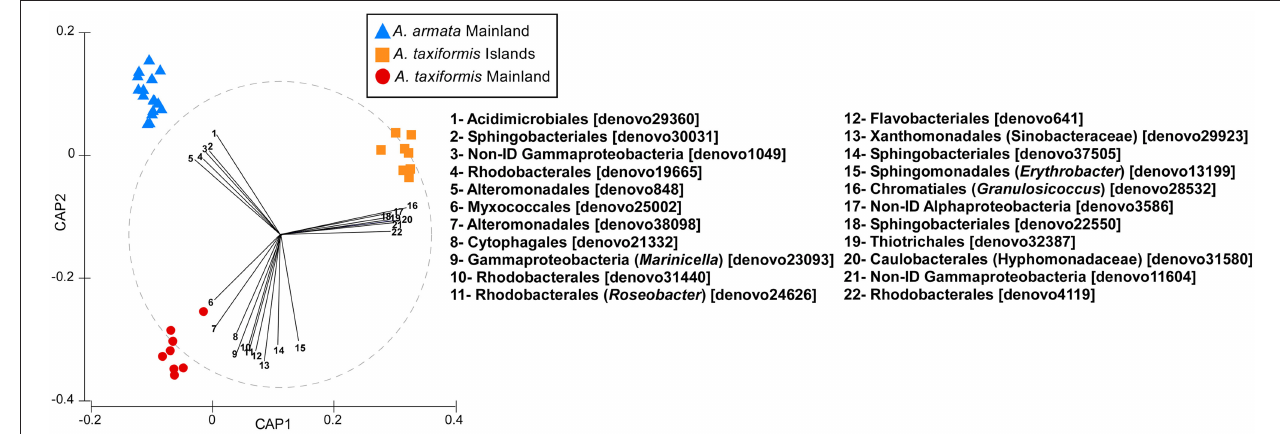
FIGURE 3 | Canonical analysis of Principle coordinates (CAP) plot showing the bacterial communities compositions of the main Asparagopsis groups (delimited according to previous statistical analyses). OTUs with Pearson’s correlation > 0.70 have been overlaid on the plot as vectors. Graphic was changed as described in the main